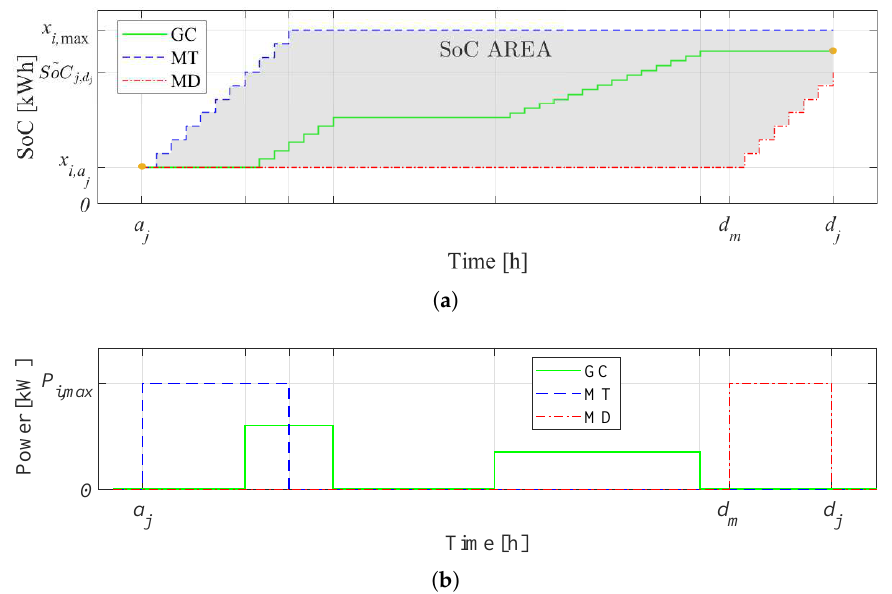
Figure 3. SoC area in an EV charger. ( a ) SoC area with an example of a SoC profile (continuous green line). ( b ) Charging power